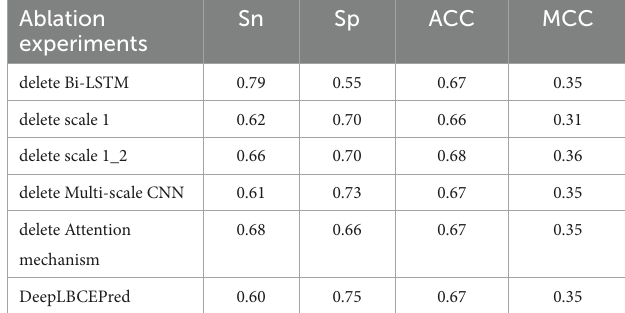
TABLE 8 Comparison of five ablation experiments on the IDED 1246 independent